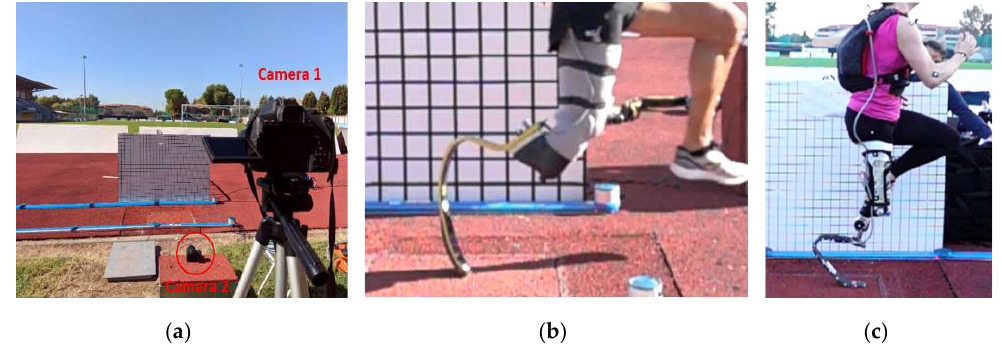
Figure 8. Field test session setup: ( a ) experimental setup on the track equipped with force platform and high-speed video cameras, ( b ) athlete TT1 valid step on force platform with simultaneous collection of GRF from force platform and the iRPF, and ( c ) athlete KD2 valid step on force platform (mirrored image).